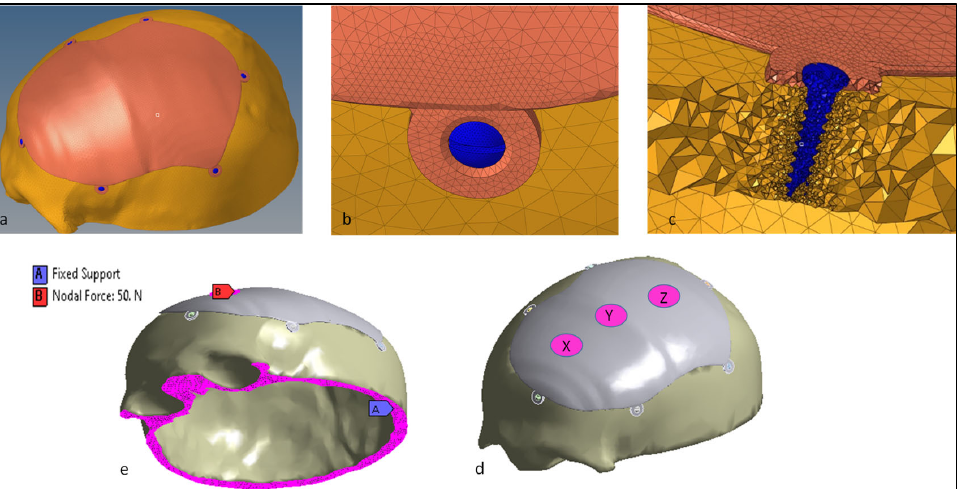
Figure 4. ( a ) Cranial PEEK implant on the skull model; ( b ) mesh generation; ( c ) cross-sectional view of the screw, implant and bone; ( d ) exertion of forces at the three implant regions; ( e ) representation of the fixed supports and the nodal force.